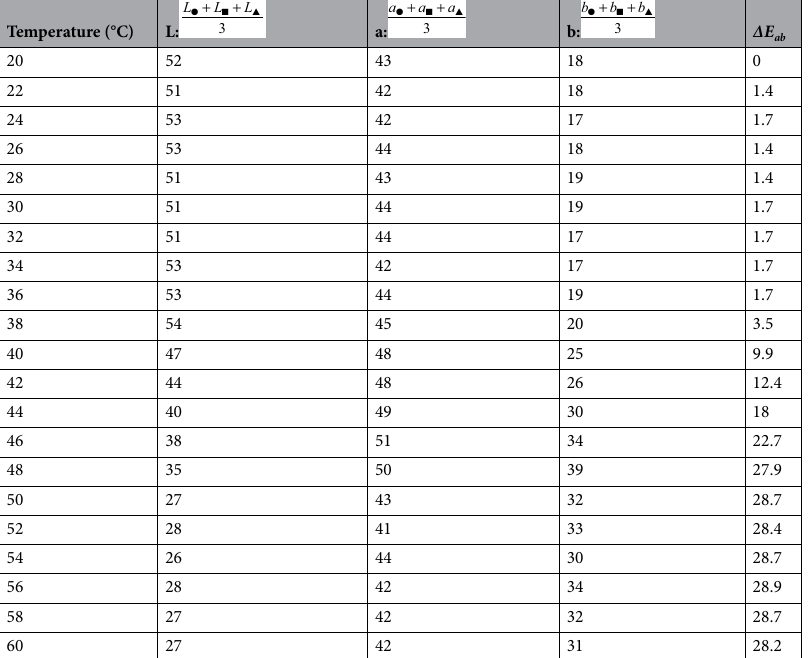
Table 2. The colour parameters of the R-PTC surface at temperatures from 20 to 60